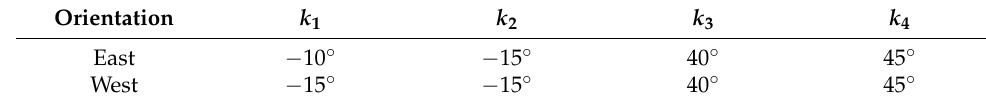
Table 4. Optimum slat angle for the east and west zones in the adaptive shading design option.